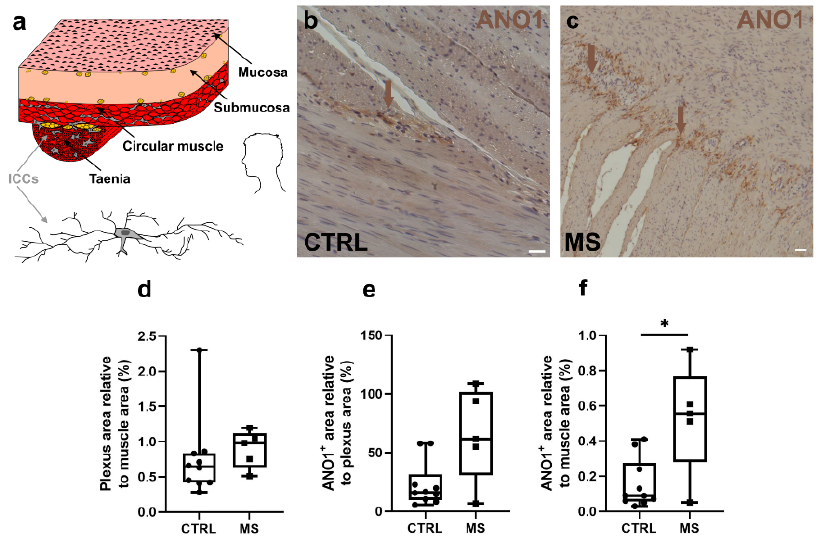
Figure 6. Immunohistological staining of the myenteric plexus (MP) of patients with multiple sclerosis (MS) ( n = 5) and non-MS controls (CTRLs) ( n = 10). Paraffin-embedded human colon tissue was obtained from patients with MS and matched CTRLs. For analysis of anoctamin 1 (ANO1), only tissue containing MP was included. ( a ) Schematic representation of ICCs and their location within the gastrointestinal wall. ( b , c ) Representative images stained for ANO1 ( brown arrow ) were selected from ( b ) a CTRL patient and ( c ) a patient with MS. Scale bars denote 50 µm. ( d , f ) Areas of ( d ) plexus expressed in relation to the area of longitudinal and circular muscle, ( e ) ANO1 + signal in relation to the plexus area, and ( f ) ANO1 + signal in relation to the area of longitudinal and circular muscle. Individual data points are patient mean values. The box and whisker plots show median values, together with the interquartile range. Statistical significance was determined by Mann–Whitney U test with * p < 0.05.